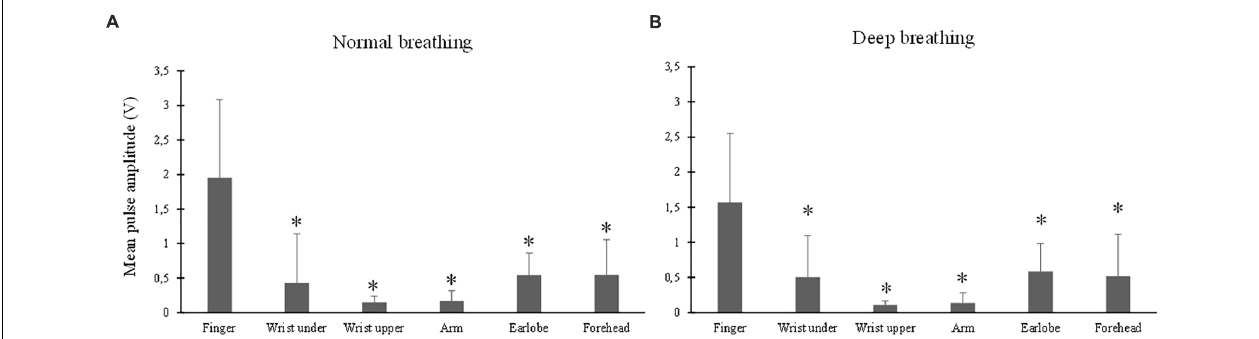
FIGURE 4 | Mean amplitude of PPG waveform measured from different sites under both normal (A) and deep (B) breathing patterns. ∗ Marks the significant differences in comparison with that from the finger ( p < 0.05).